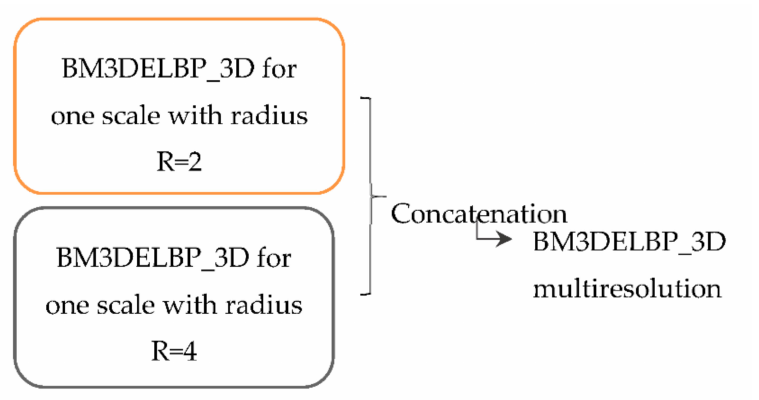
Figure 5. The multi-resolution strategy for BM3DELBP_3D (© [2020] IEEE. Reprinted [adapted], with permission, from